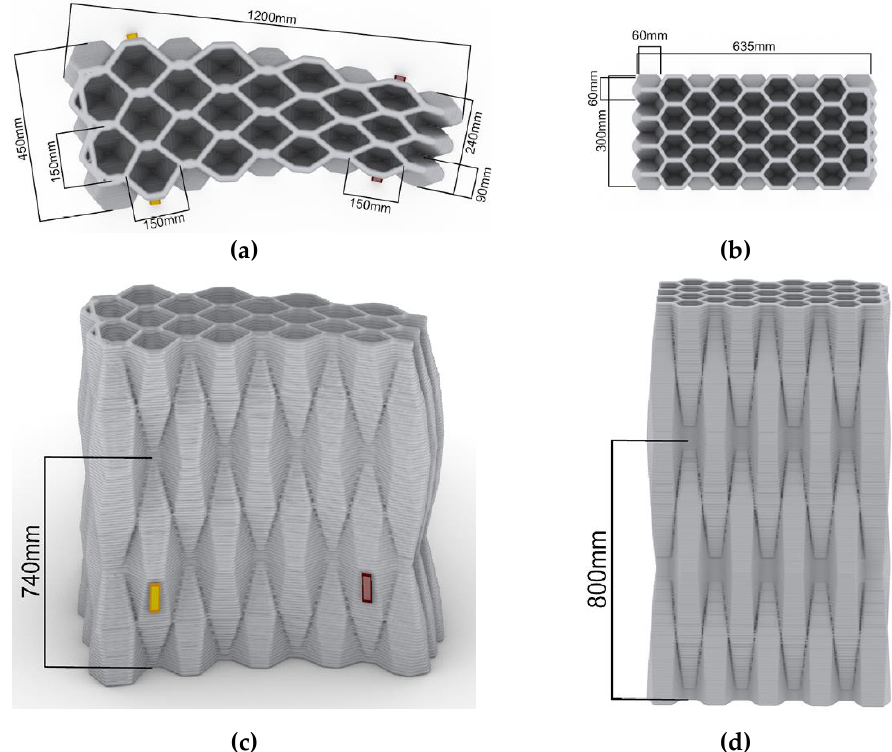
Figure 7. Visualization of the existing prototype ( a , c ) and the optimized geometry ( b , d ) with relevant dimensions: top view ( a , b ) and perspective view ( c , d ). Sensor locations ( a , c ) for heat flux measurements cycle 1 and cycle 3 are highlighted in yellow while the sensor locations for measurement cycle 2 are highlighted in red.